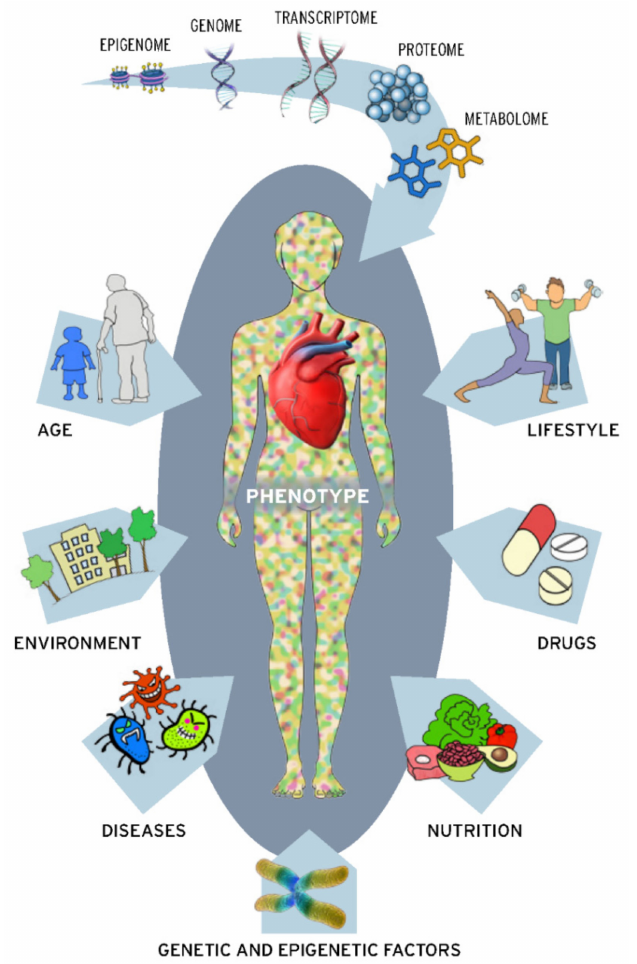
Figure 1. Overview of the -omic hieararchy and contributing factors to an individual’s